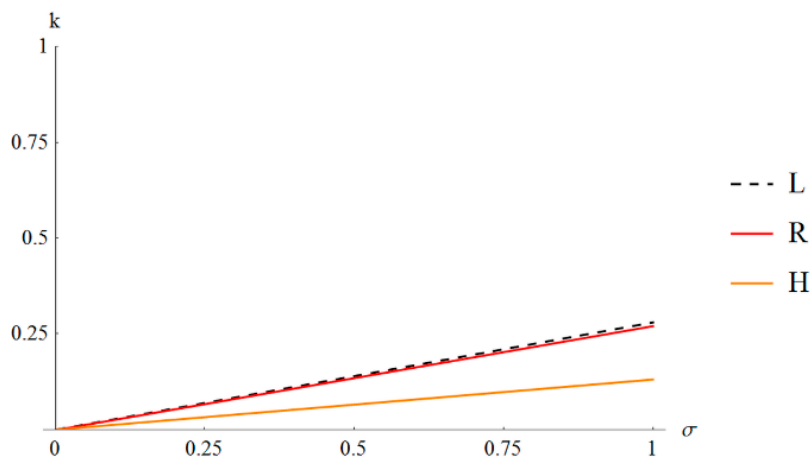
Figure 5. Lines of zero value of the lowest eigenvalue.